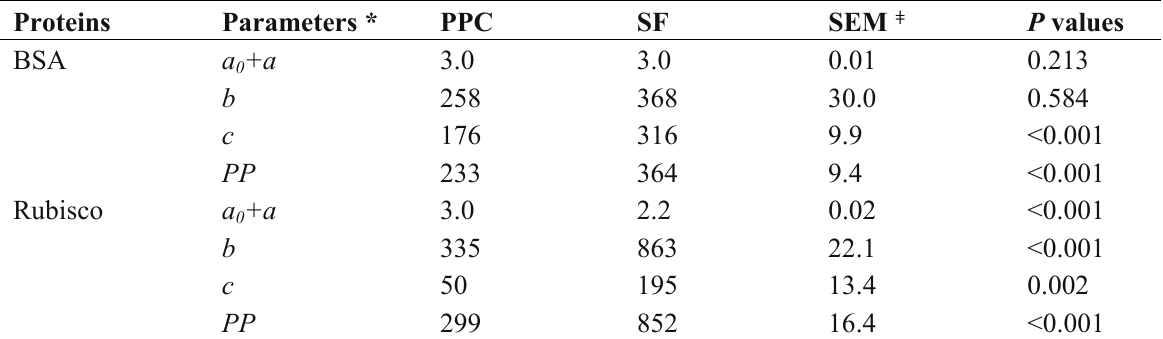
Table 1. Parameters of precipitating capacities of purple prairie clover (PPC; Dalea purpurea Vent.) and sainfoin (SF; Onobrychis viciifolia ) condensed tannins (CT) with bovine serum albumin (BSA) and ribulose 1, 5-disphosphate carboxylase (Rubisco) protein. Proteins